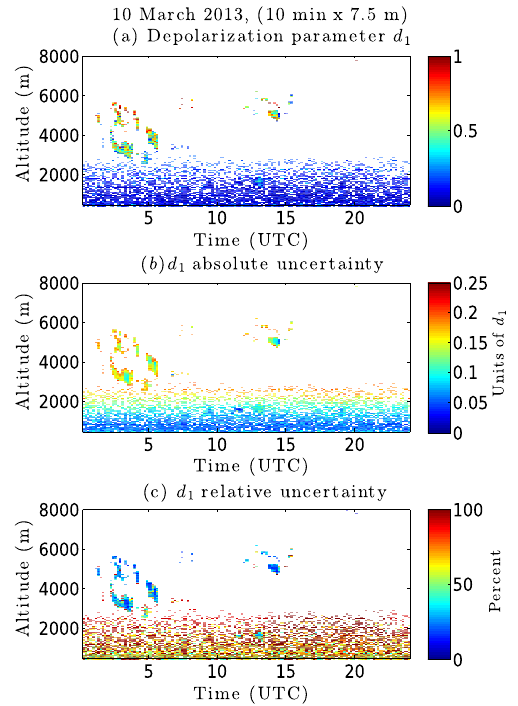
Figure 10. The d 1 depolarization values from 10 March 2013, with 10min × 7.5m resolution, excluding anywhere with more than 0.2 absolute uncertainty in units of depolarization parameter: (a) d 1 values, (b) uncertainties associated with the d 1 values in units of depolarization parameter, and (c) relative uncertainties in units of percent.